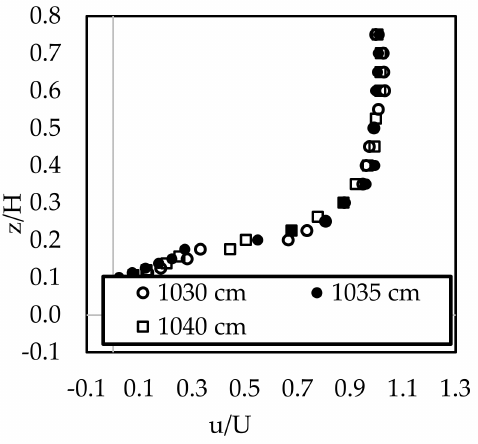
Figure 3. Investigation of flow development in the measurement’s places.